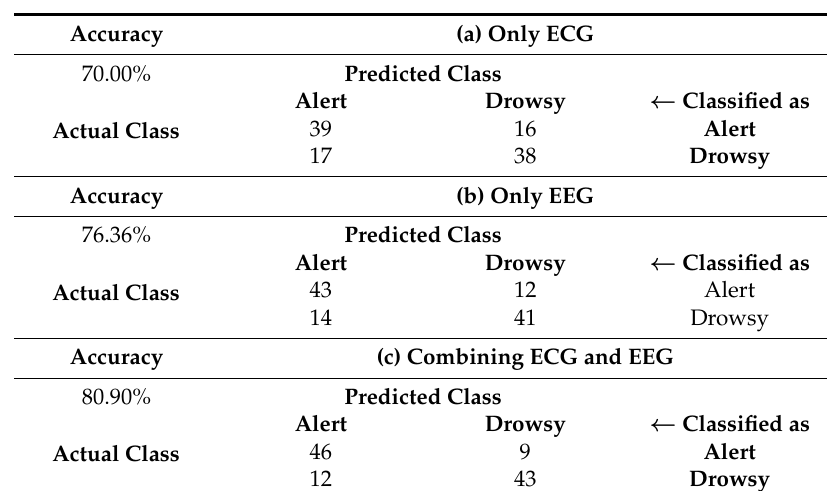
Table 4. Performance analysis by combining physiological